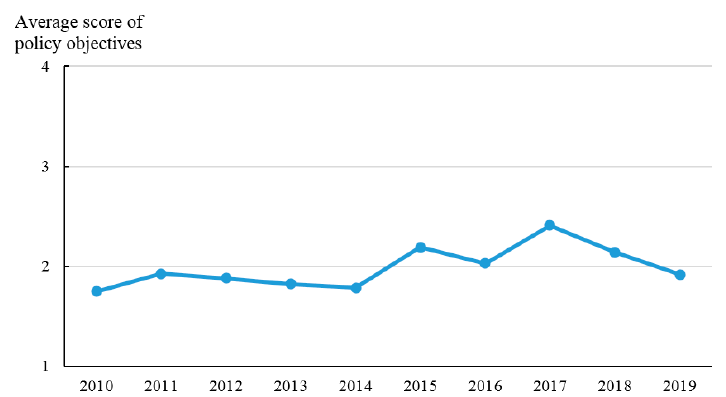
Figure 6. Average score Policy objectives from 2010 to 2019.